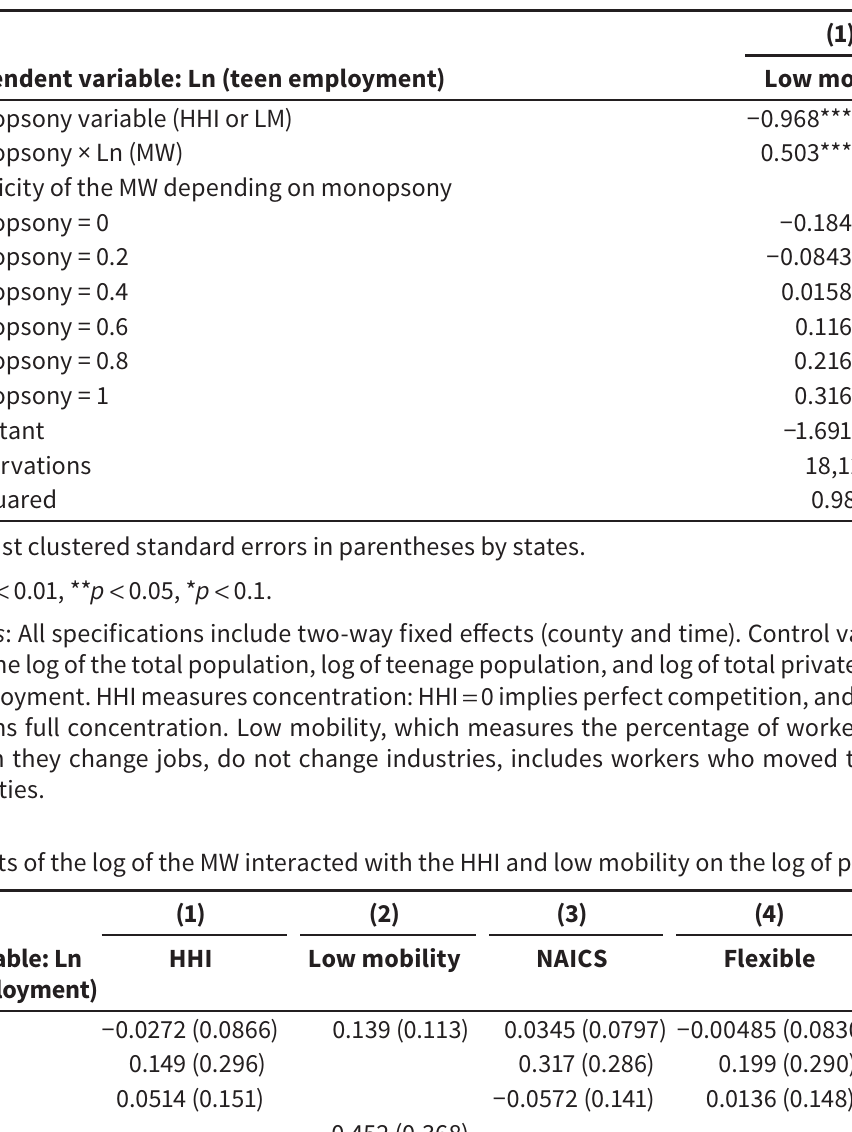
Effects of the log of the MW interacted with the low mobility on the log of teenage employment (low mobility using workers who moved to other county)